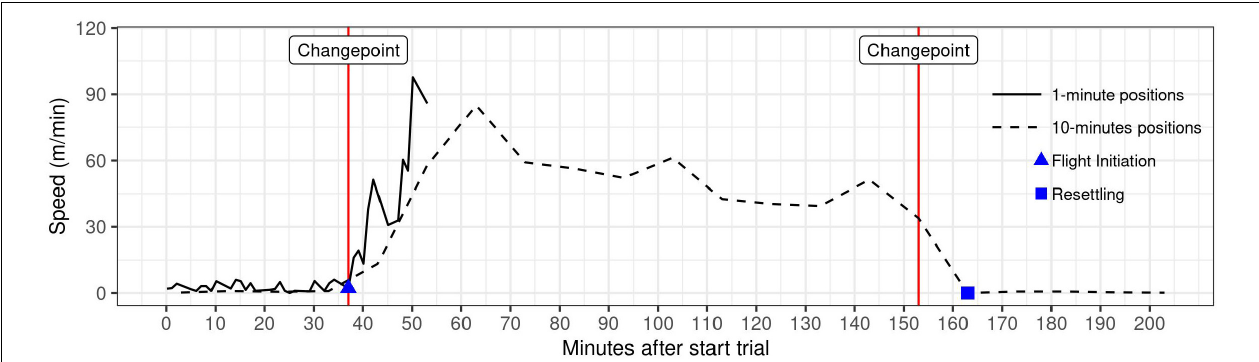
FIGURE 3 | Visualization of the detection of flight initiation and resettling positions of a wolf during experimental human approach trials. For detection, we used changepoint analysis with change in mean and variance of wolf movement speed using the MBIC penalty. The first changepoint indicates the moment of flight initiation based on 1-min GPS positioning intervals (solid line). Resettling location is defined as the first position after the first changepoint after flight initiation, based on 10-min positioning intervals (dashed line).